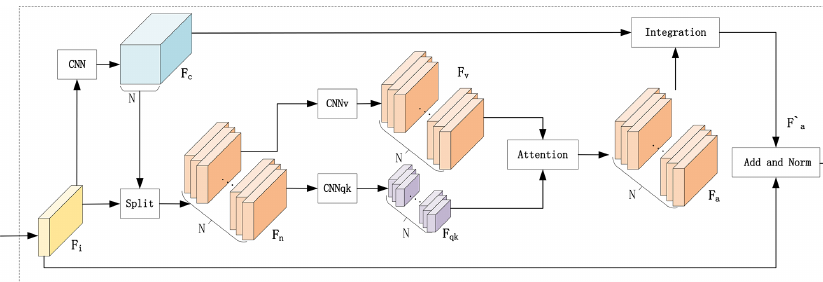
Figure 4. The structure of Region Attention Block (RAB).